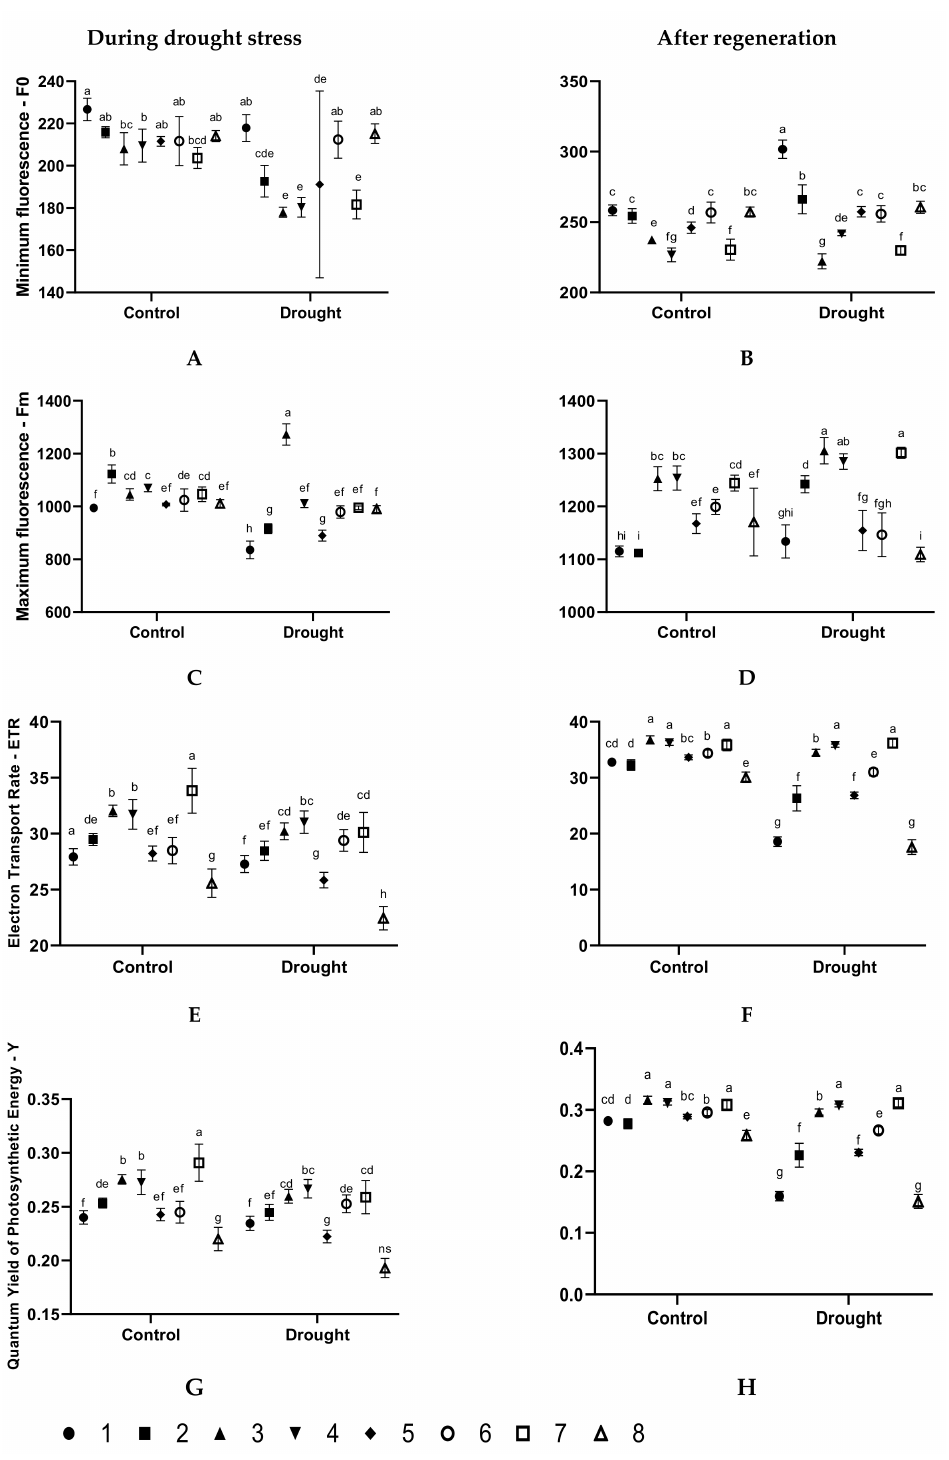
Figure 1. Parameters of chlorophyll fluorescence (non-nominated units): left column graphs imaging measurements during drought stress and right column graphs imaging measurements after regeneration. Letters a-i indicate statistically di ff erent mean values ( p <